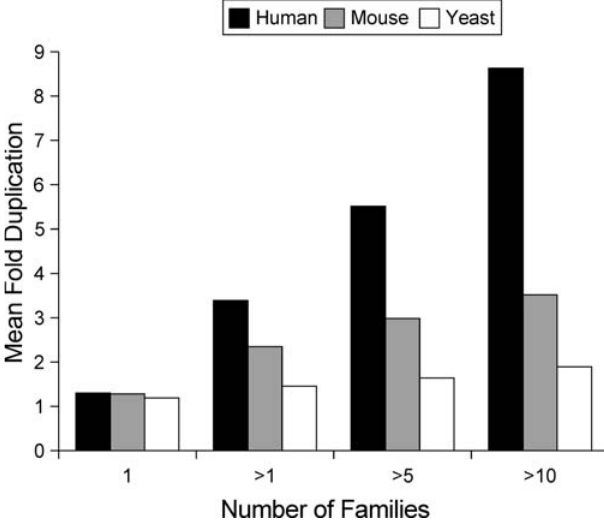
Figure 5. Fold Duplication and Family Counts of Ancient Folds Ancient SCOP folds were divided into a number of bins according to the number of families that they contain ( x -axis). The maximum number of times each fold is reused in the same protein was counted. The mean count for each bin is shown for human, mouse, and yeast proteins. As the number of families in a SCOP fold increases, the maximum number of times the fold is duplicated in proteins also tends to increase. The differences in magnitude of duplication between folds with one family and folds with more than one family are significant (MW-test, KS-test: p , 0.01). The differences in fold duplication between human, mouse, and yeast are larger for folds with larger numbers of families. The differences between folds with one family and folds with more than one family with respect to mammals and yeast are significant (MW-test: p , 0.05; KS-test: p , 0.001). The significance of the differences between human and mouse could not be